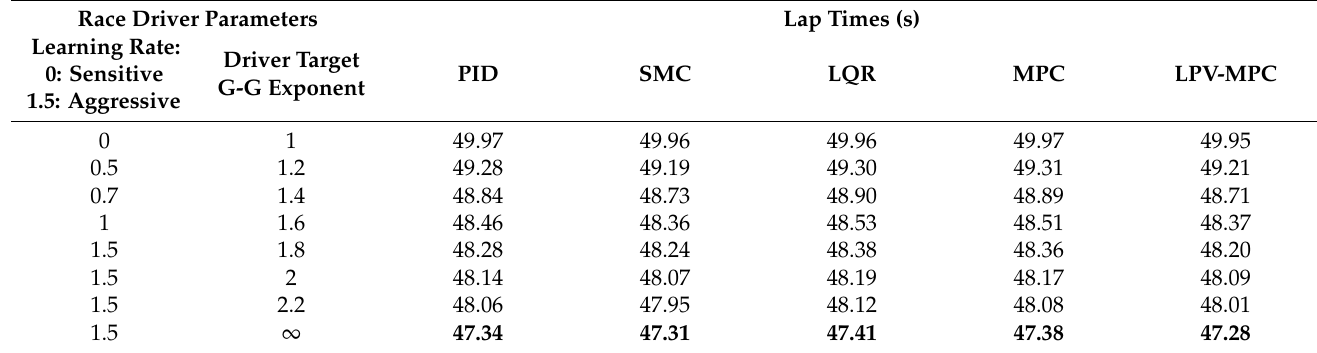
Table 9. Lap times at Hockenheim 2010 Formula Student.